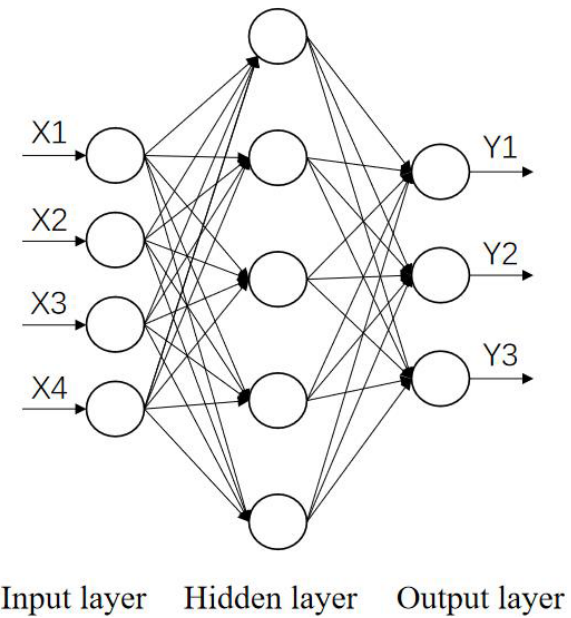
Figure 6. The structure of the BP neural